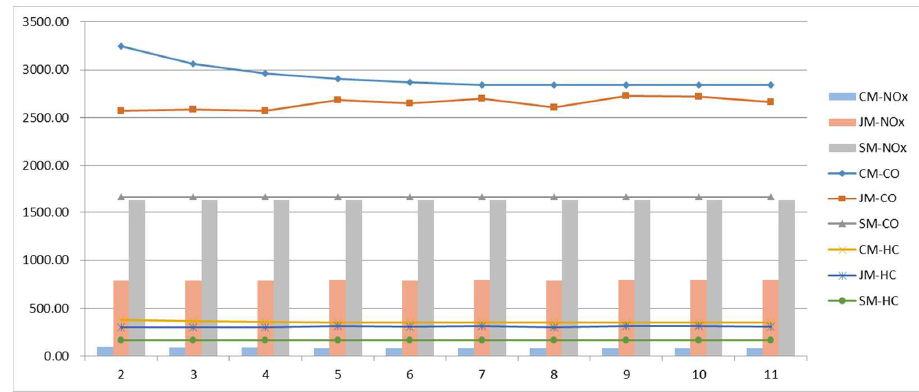
Figure 17. Pollutant emissions variations with parameter s .